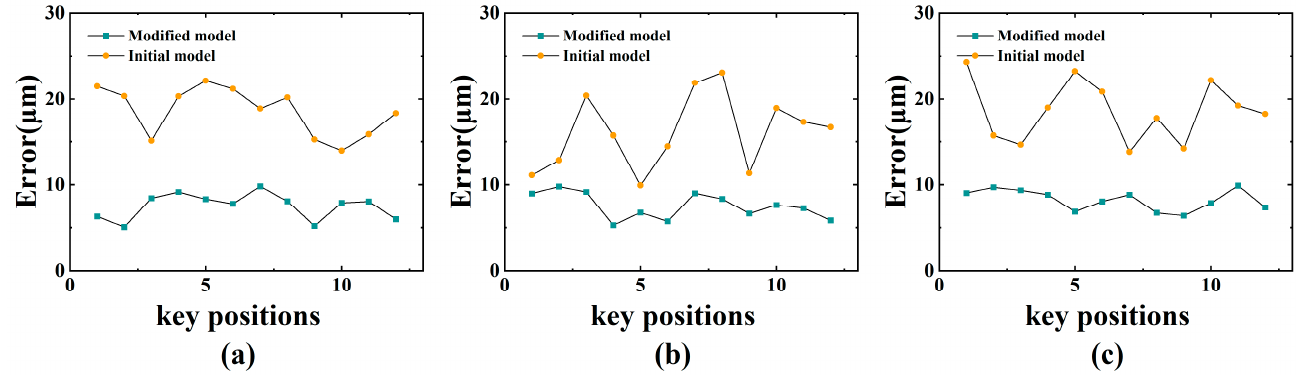
Figure 19. Comparison of calculation errors before and after finite element model correction at key positions ( a ) X-direction ( b ) Y-direction ( c ) Z-direction.